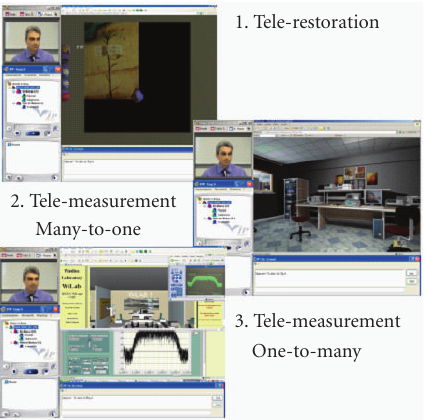
Figure 5: GUI in the laboratory